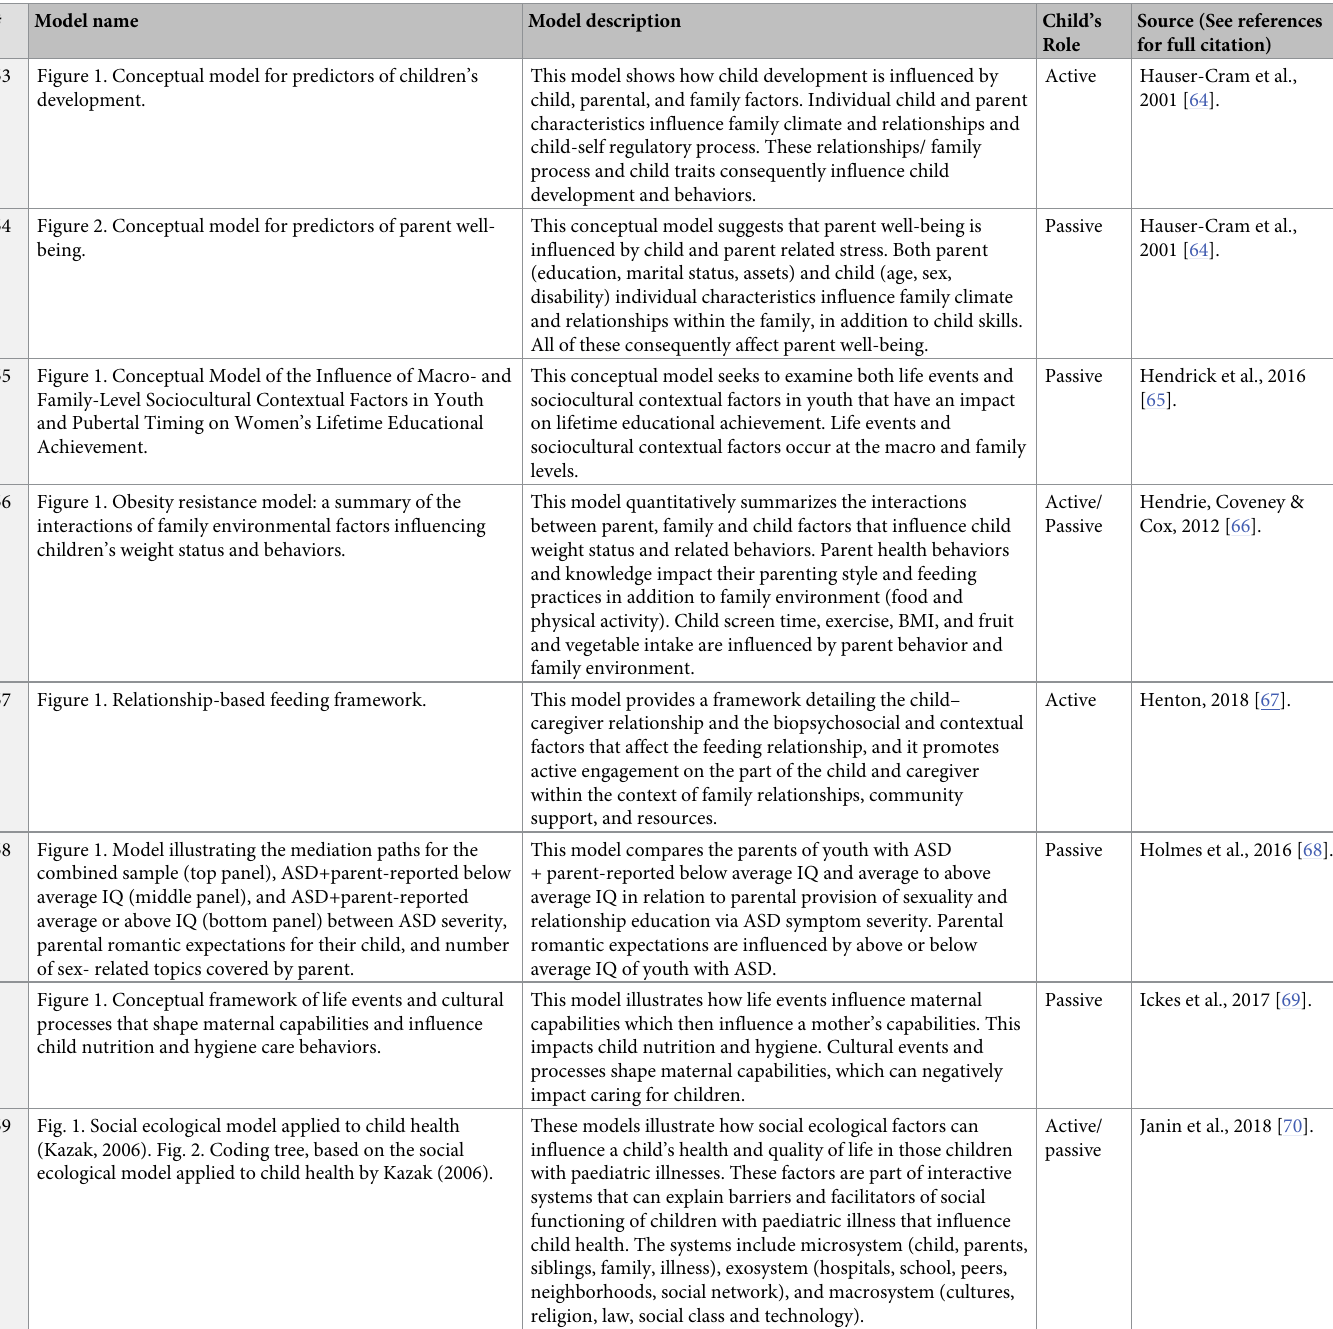
Figure 1. Conceptual model for predictors of children’s development.